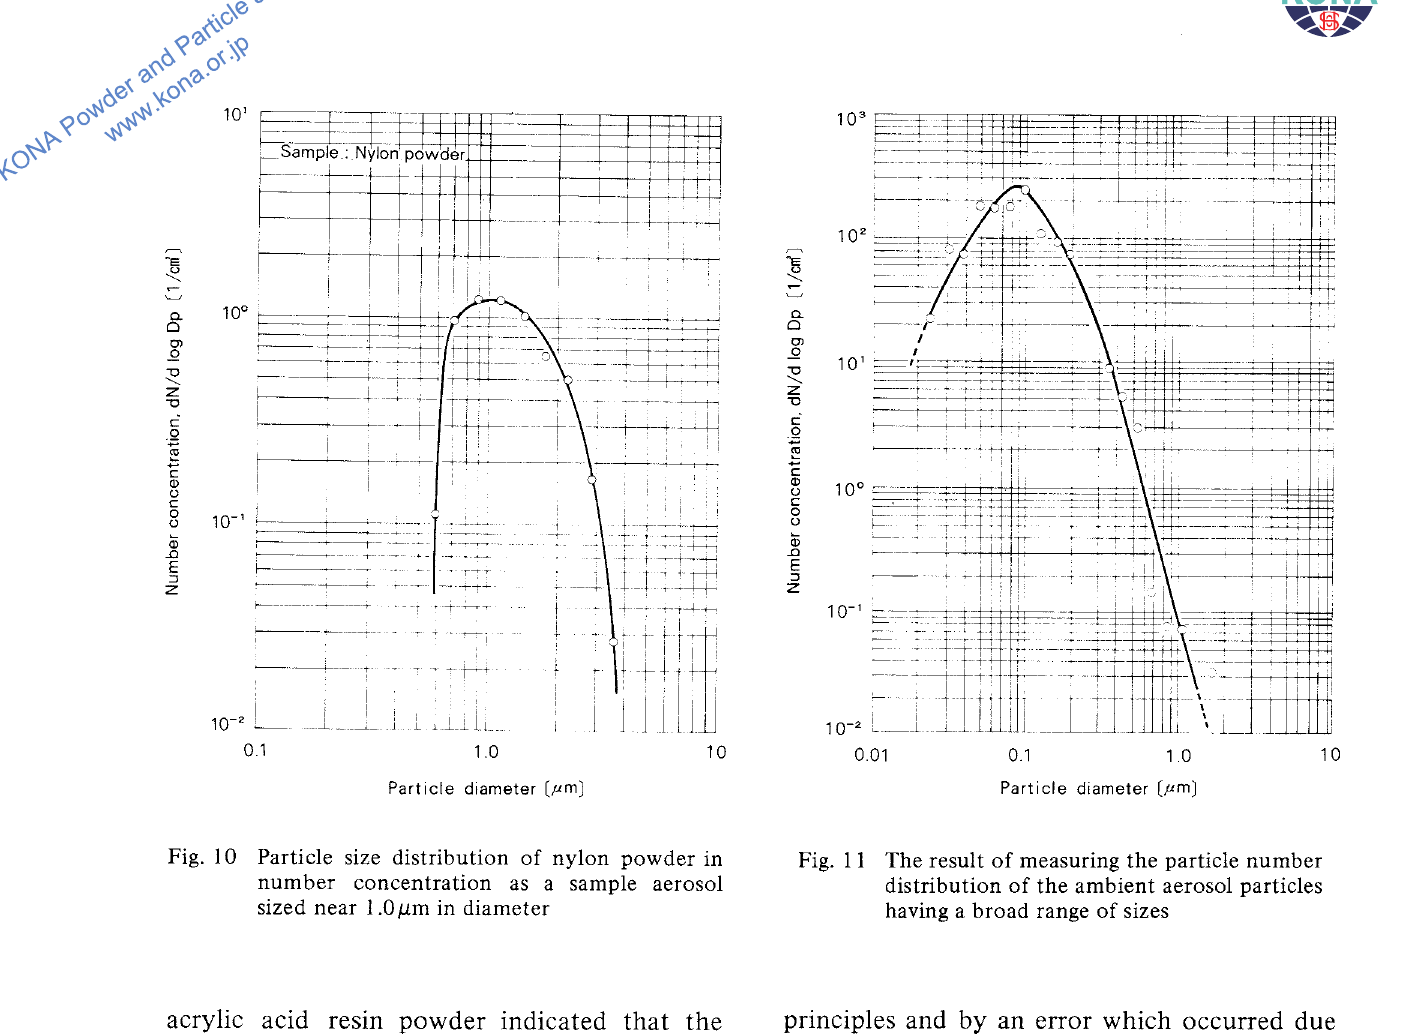
Fig. I 0 Particle size distribution of nylon powder in number concentration as a sample aerosol sized near I .0 J.lm in diameter